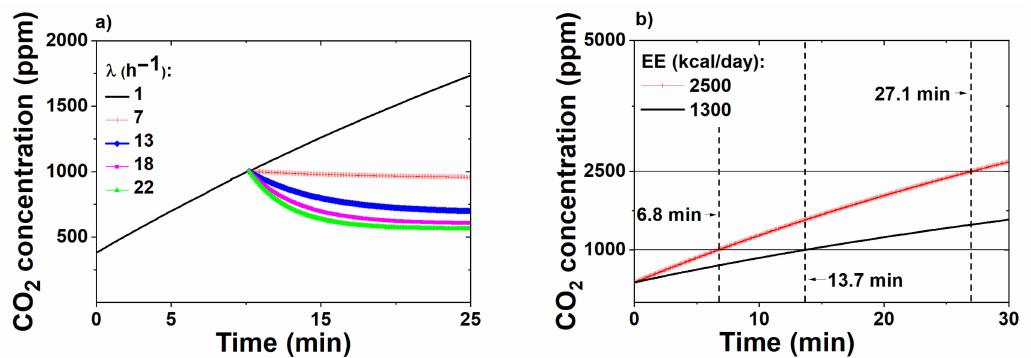
Figure 7. ( a ) Model CO 2 concentration profile showing e ff ect of air exchange rate on CO 2 level; ( b ) Modeled CO 2 concentration profile showing e ff ect of metabolic rate on growth